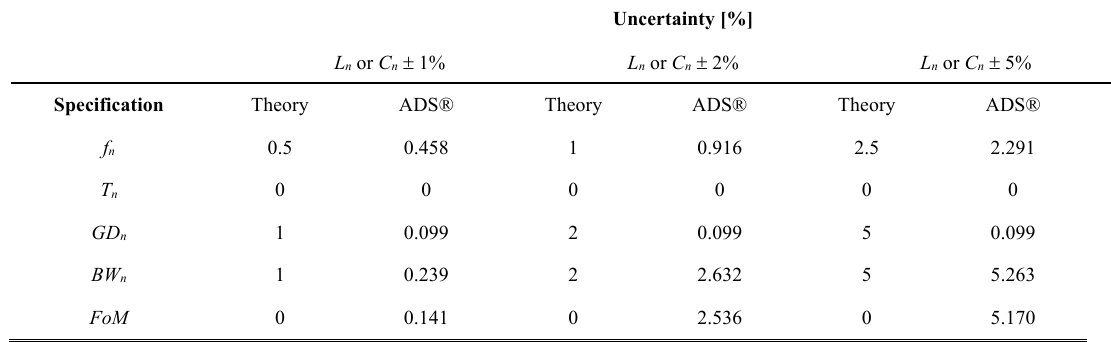
TABLE VI. UAs of NGD specifications according to variations of L n (or C n